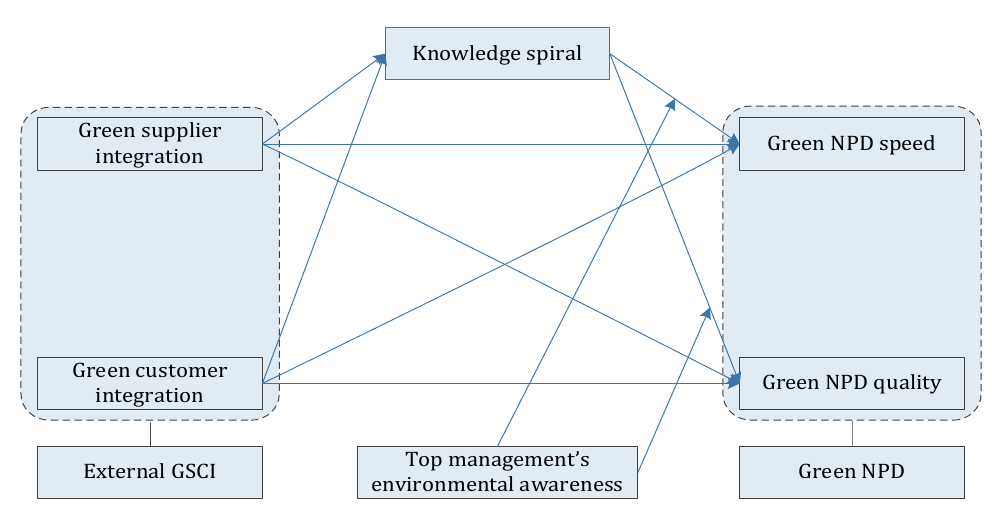
Figure 1. Research model.